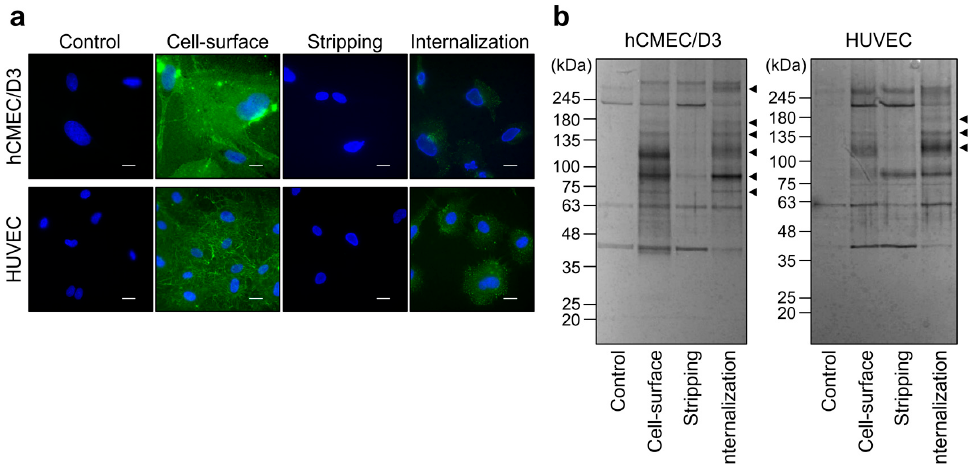
Figure 2. Internalization of biotinylated cell-surface proteins in hCMEC/D3 cells and human umbilical vein endothelial cells (HUVECs). ( a ) Representative fluorescence images of biotinylated proteins detected by FITC-labeled streptavidin (green) in hCMEC/D3 cells and HUVECs. The biotinylated proteins were stained with FITC-streptavidin (green), and the nuclei were stained with DAPI (blue). Fluorescence in the cells was observed using fluorescence microscopy ( n = 3). Scale bar, 20 μ m. ( b ) Representative silver staining images of biotinylated proteins eluted from streptavidin magnetic beads. Following solubilization of the cells, the biotinylated proteins from each fraction were recovered using streptavidin magnetic beads. The proteins bound to streptavidin magnetic beads were eluted by DTT, then subjected to SDS-PAGE and stained by silver staining ( n = 3).